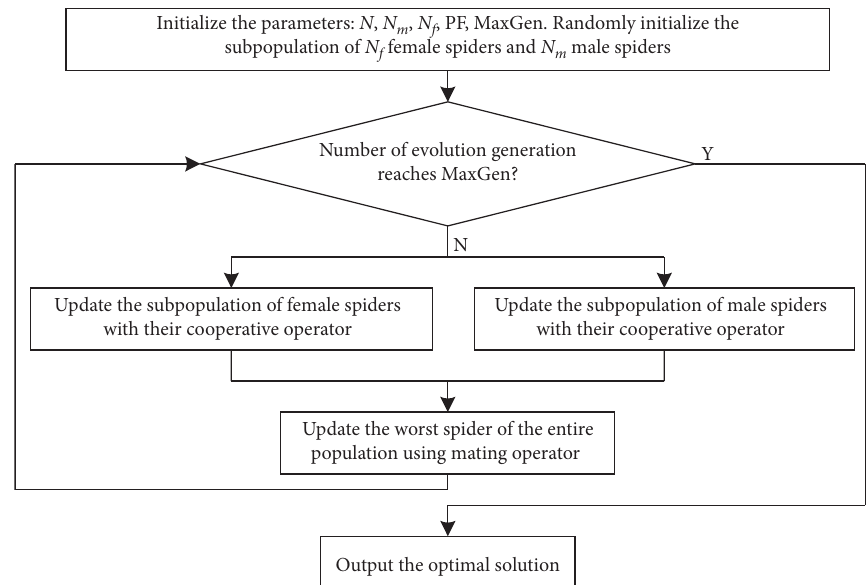
Figure 1: Flowchart of the original SSO algorithm.